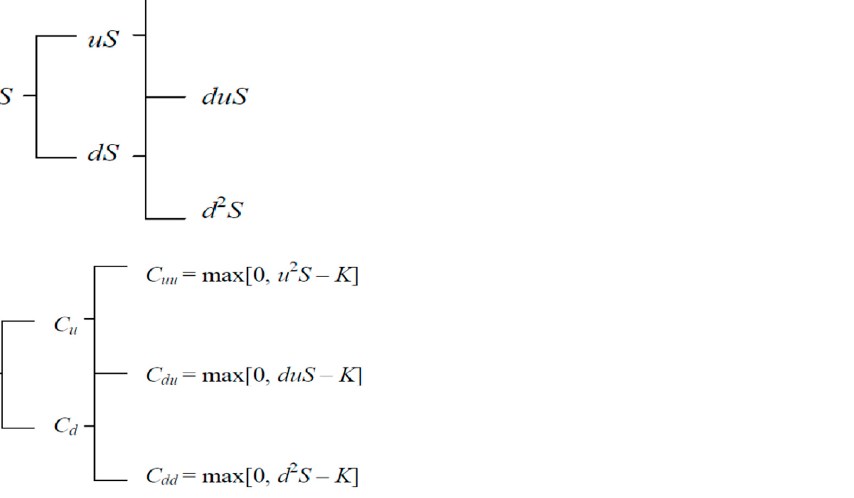
Table 1 . Required information for the assessment of the present value of real options.